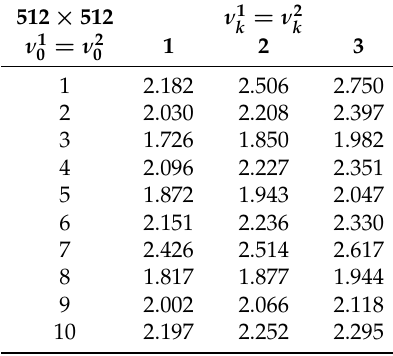
Table 4. Average CPU times for various relaxation numbers on finest multigrid level ( ν 1